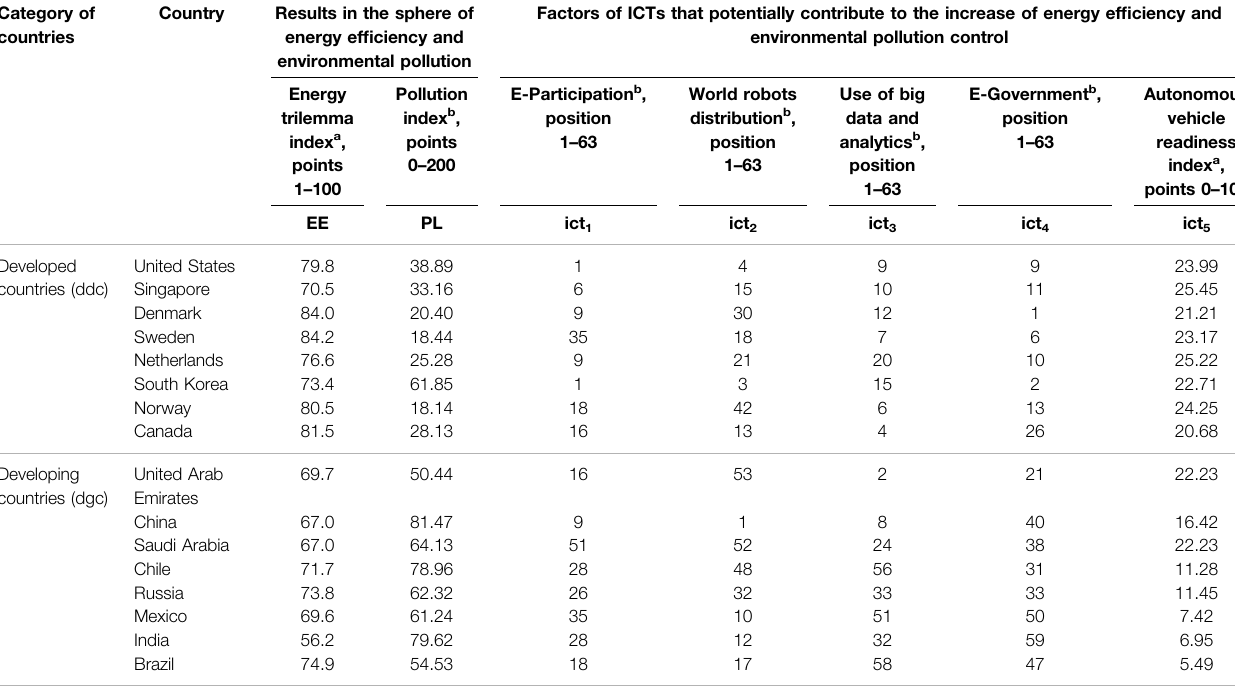
FIGURE1| AssessmentofthetechnologicalreadinessofdevelopedanddevelopingcountriestoimplementtheecologicalblockoftheSDGsin2020,points1 – 63.